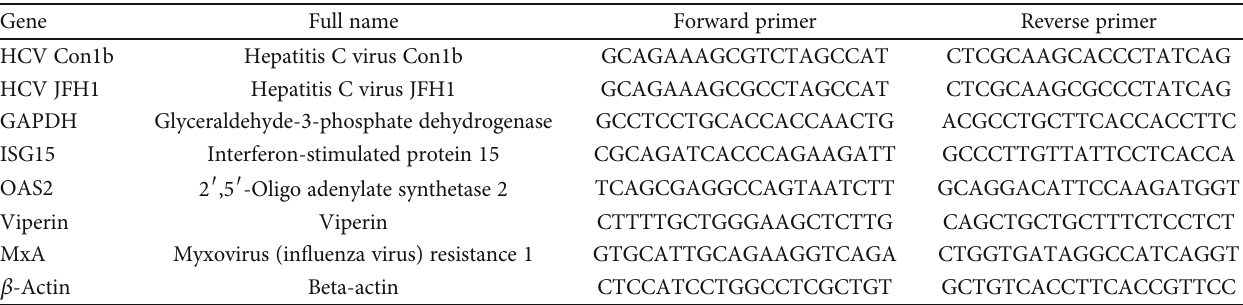
Table 1: Primers used for real-time